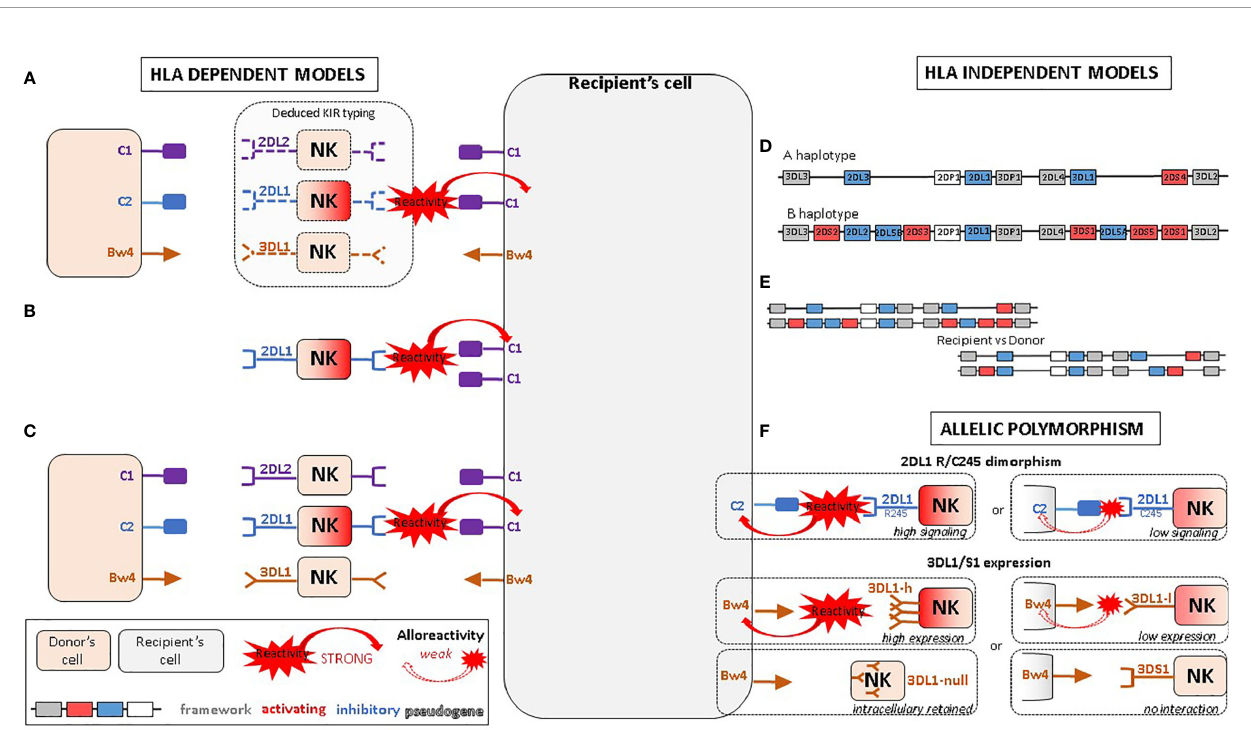
FIGURE 1 | Proposed NK alloreactivity mechanisms in aHSCT according to different models. (A) Ligand – ligand model confronts the MHC of the donor with the MHC of the recipient: KIR genotyping is unknown and NK alloreactivity of the donor toward host cells is expected when the recipient lacks MHC class I ligand present in the donor. (B) Receptor – ligand model considers the KIR of the donor and the MHC of the recipient: if at least one KIR gene expressed in the donor does not recognize any of the MHC molecules of the recipient ( “ missing-ligand ” ), the NK cells of the donor will increase their cytotoxic activity. (C) Educational models consider the MHC class I molecules of the donor and recipient and the KIR typing of the donor. It should re fl ect the “ education ” process required for NK cells to become competent. (D) The KIR haplotypes of the donor: the B/x of the donor and particularly those carrying Cen-B/B are expected to be more alloreactive toward the cell of the recipients, as they carry mostly activating KIR genes. (E) KIR matching models represent the number of aKIR and/or iKIR gene present in the donor but absent in the recipient and vice versa. (F) KIR polymorphism leads to KIR molecules with relevant biological